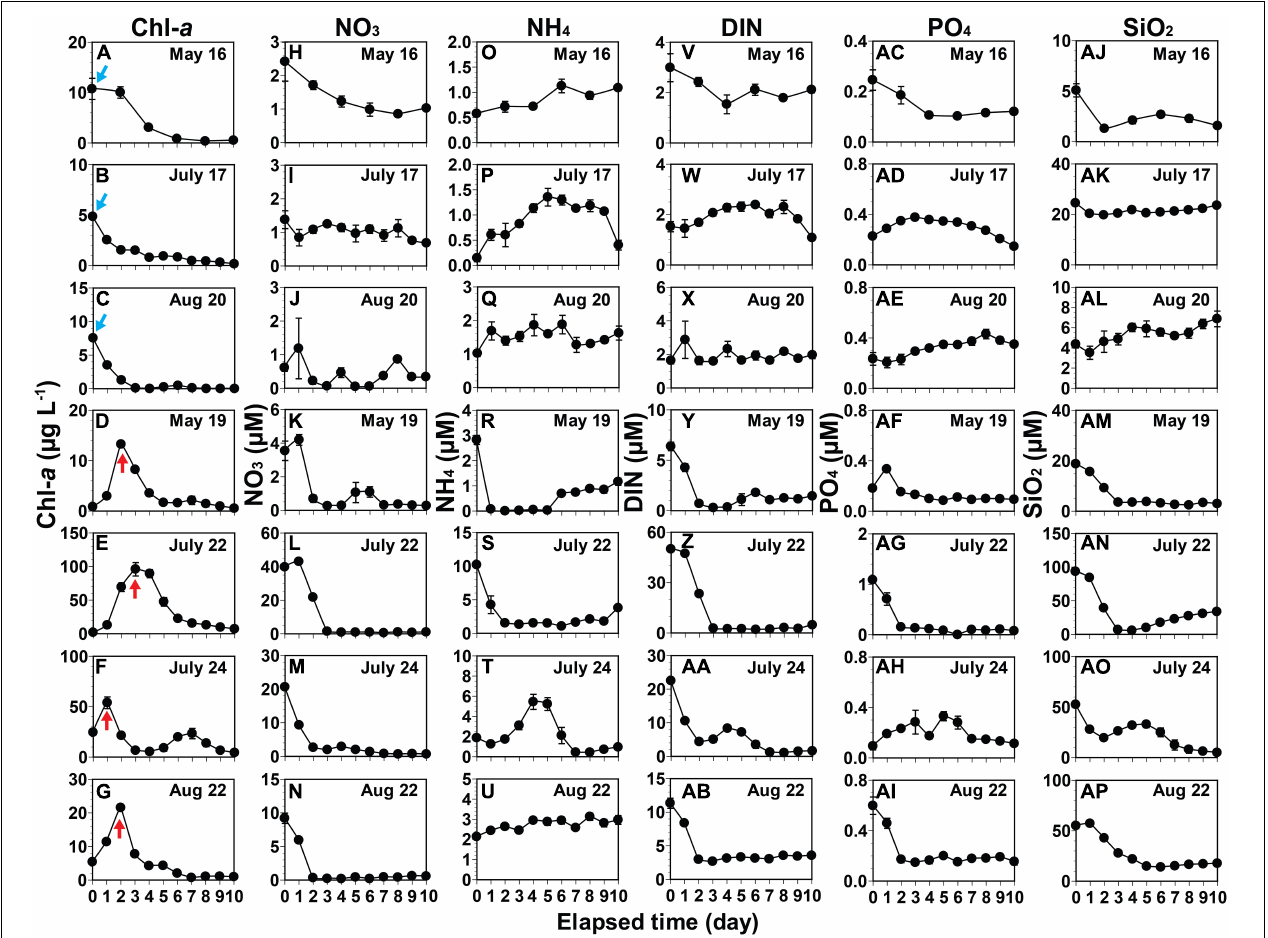
FIGURE 5 | Variations in the concentrations of chlorophyll- a (Chl- a ) and nutrients. Chl- a (A–G) , nitrate (NO 3 ) (H–N) , ammonium (NH 4 ) (O–U) , dissolved inorganic nitrogen (DIN) (V–AB) , phosphate (PO 4 ) (AC–AI) , and silicate (SiO 2 ) (AJ–AP) during incubation of seawaters. A blue arrow indicates the highest Chl- a in the seawater where any increase in Chl- a did not occur during incubation. A red arrow indicates the Chl- a peak in the seawater where increases in Chl- a occurred during incubation. The date in each box indicates the sampling date of the seawater collected from St. Gyedong (August 22) or St. Gukdong (the remaining dates) in 2019. Vertical symbols represent treatment means ± 1